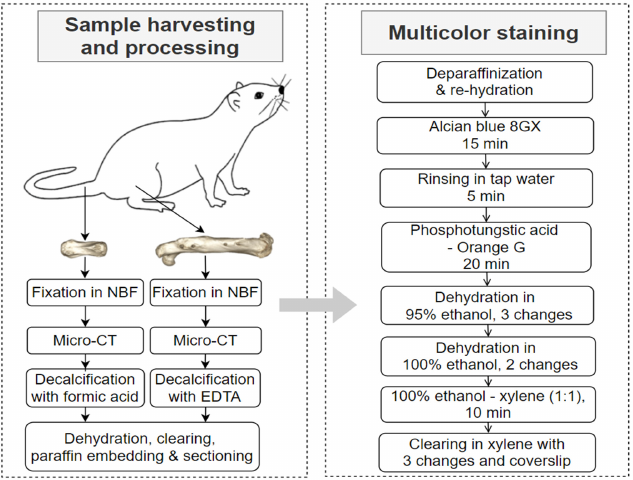
Figure 1. Sample harvesting, processing and the multicolor staining procedure. Note: decalcification solutions: 20% EDTA or 5% formic acid (NBF: neutral-buffered formalin; EDTA: ethylenediaminetetraacetic acid).